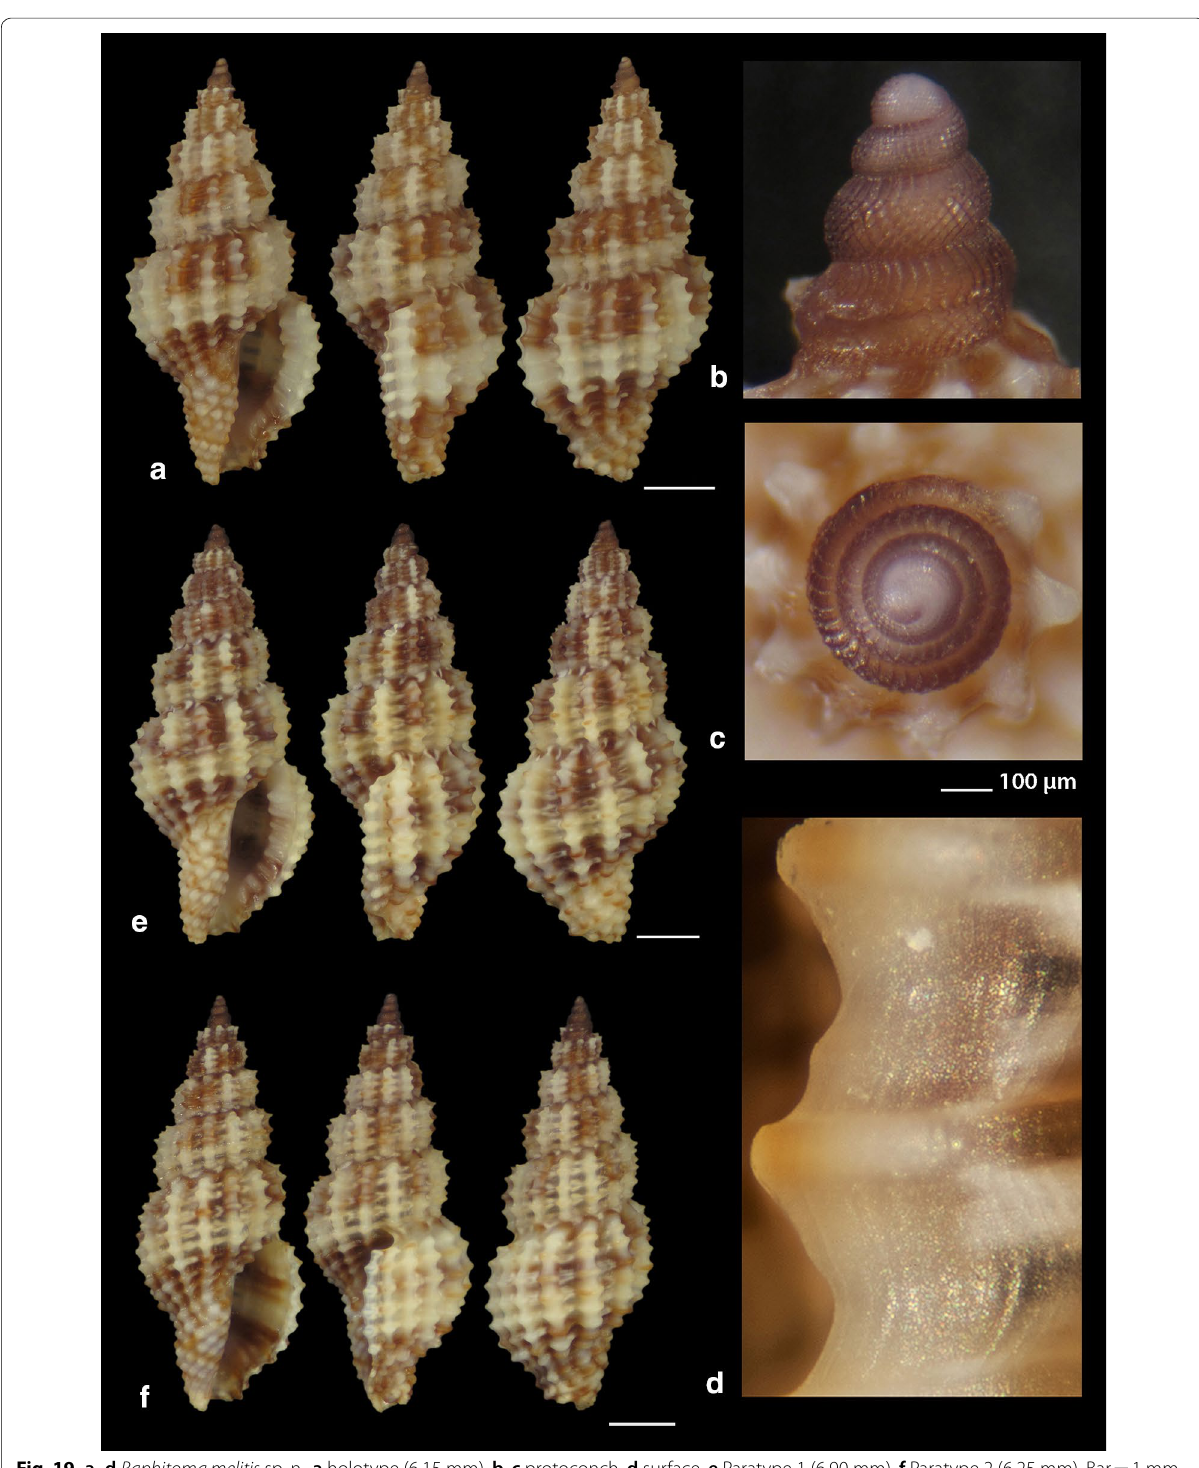
Fig. 19 a – d Raphitoma melitis sp. n., a holotype (6.15 mm), b , c protoconch, d surface, e Paratype 1 (6.90 mm), f Paratype 2 (6.25 mm). Bar unless otherwise